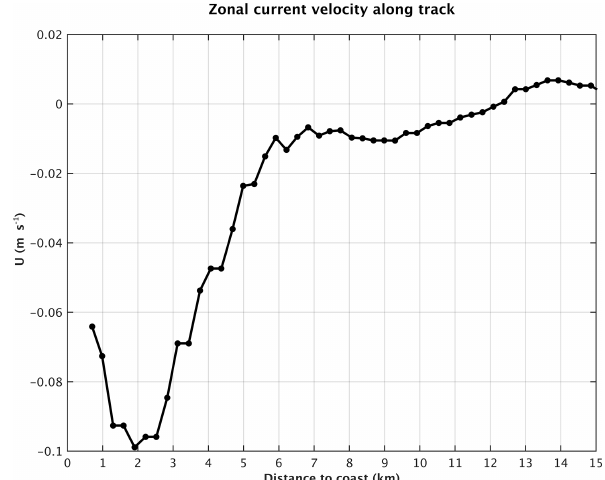
Figure 19. Barotropic current (zonal component U) for January 2014 based on the MARS3D hydrographic model interpolated along the Jason track against the distance to the coast. Negative val- ues mean westward